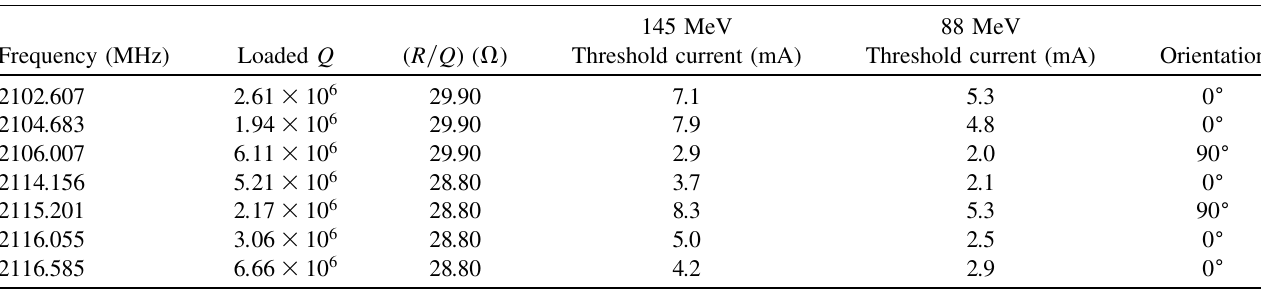
TABLE 1. Summary of the simulation results showing mode properties of those HOMs which are predicted to produce threshold currents below 10 mA with the FEL configured for 145 MeVof beam energy operation. The expected threshold currents for 88 MeV operation were determined by scaling the results at 145 MeV by the ratio of the energies at the cavity containing each HOM. 145 MeV 88